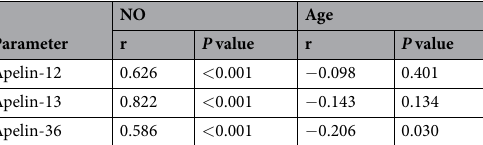
Table 4. Pearson’s correlation results between serum nitric oxide (NO) and plasma apelin levels in all participating patients (both MMD and ICAD